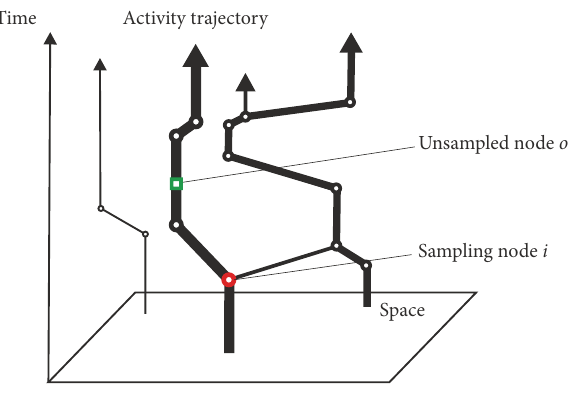
Figure 2: Activity trajectory in a three-dimensional space.